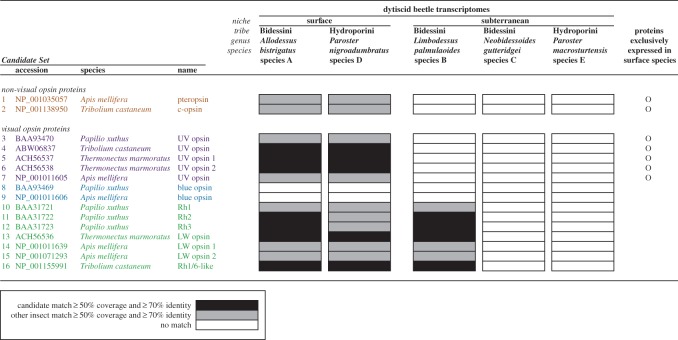
Dytiscid beetle orthologous matches to Candidate Set opsin genes. Qualitative representation of positive matches from the five targeted dytiscid beetle transcriptomes, which corresponds to BLAST search results detailed in the electronic supplementary material, table S1—Candidate Set gene numbers (1–16) and dytiscid beetle species designations (a–e). Positive matches (greater than or equal to 50% query coverage and greater than or equal to 70% identity) are defined as: match to target accession (black bar); match to other insect orthologue (grey bar); or no evidence for an orthologous match (white bar). Proteins exclusively expressed by both surface species, but absent from all subterranean species are identified by an open circle.